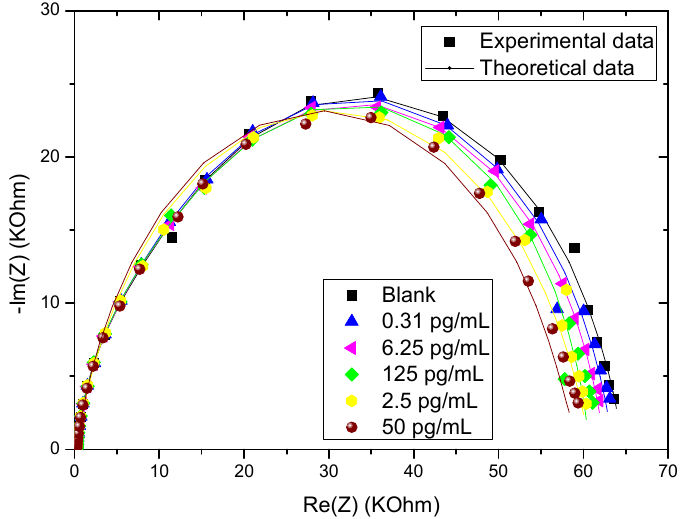
Figure 6. Experimental and theoretical EIS of CS-MIPs/CMA/Au in 5 mM [Fe(CN)6] 3 − /4 − initial potential E = 0.2 V; f = 100 kHz–100 mHz, for different concentrations of GLY (0.31 pg/mL–6.25 pg/mL–125 pg/mL–2.5 ng/mL and 50 ng/mL). Table 3. Different parameters of CS ‐ NIP/CMA/Au estimated by the model for different concentrations of GLY.